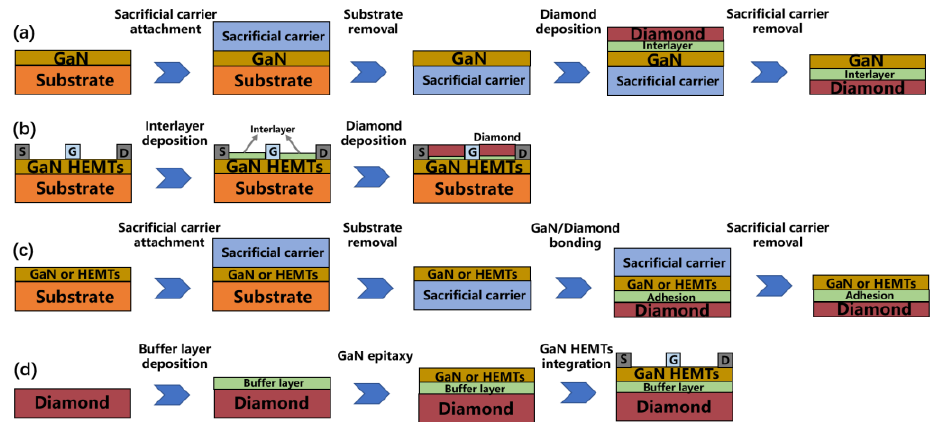
Figure 1. Fabrication of the GaN and diamond for the HEMT devices. ( a , b ): Diamond grown on the backside and the topside of HEMTs. ( c ): Diamond bonding to the GaN wafers or HEMTs. ( d ): GaN or HEMTs with epitaxial growth on the diamond substrate.